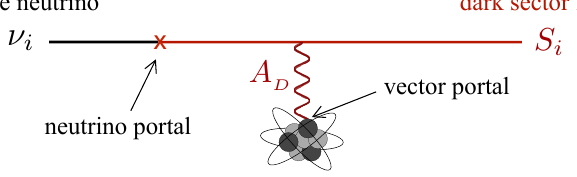
Figure 1 . A generic consequence of dark sectors with neutrino- and vector-portals are quasi-sterile neutrinos. The BSM matter potential generated by the dark vector interactions can alter neutrino oscillations in